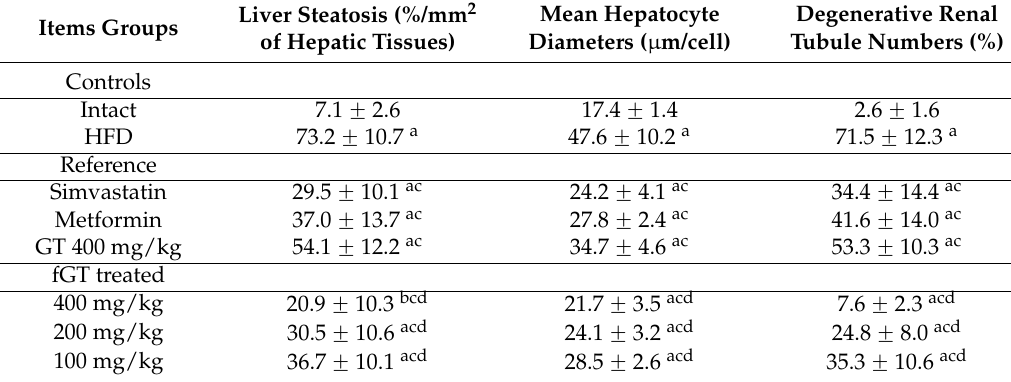
Table 8. Changes in histopathology-histomorphometry of the liver and kidney in NFD or HFD supplied